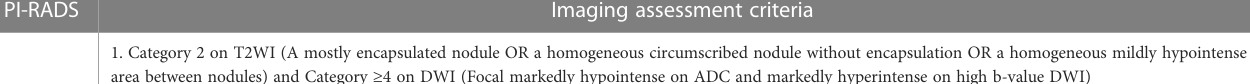
TABLE 2 Assessment criteria for transition zone PI-RADS category 3 lesions according to PI-RADS version 2.1. PI-RADS Imaging assessment